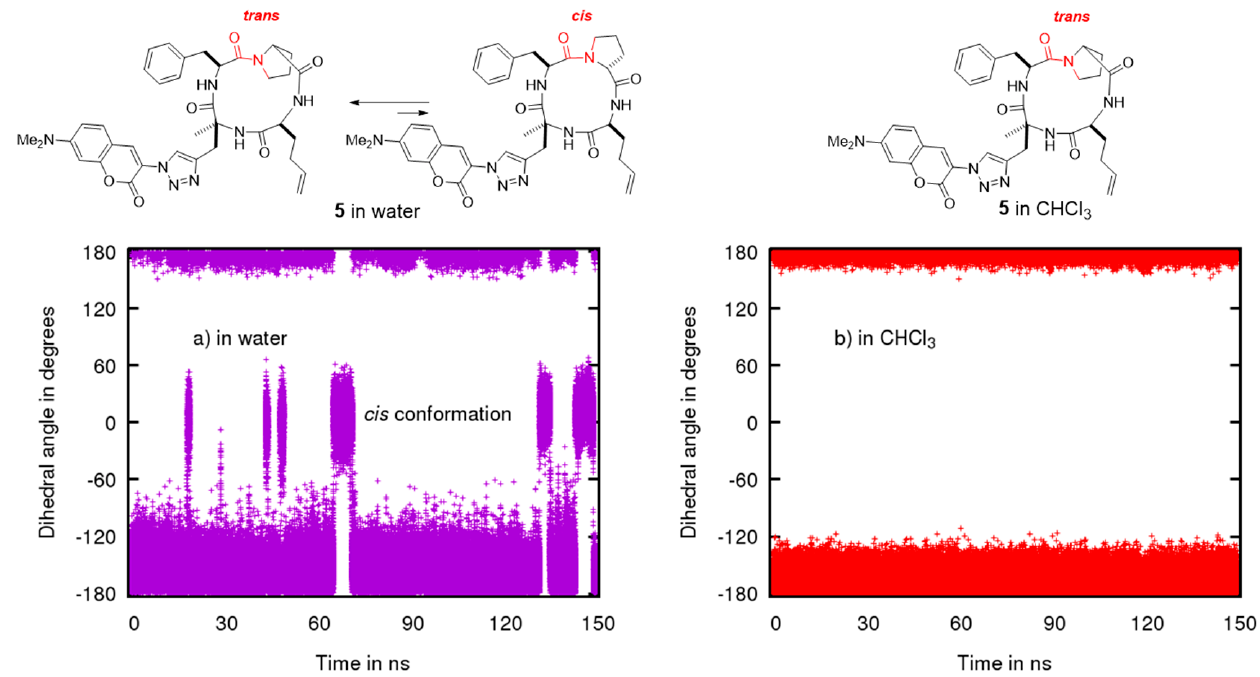
Figure 7. Evolution of the dihedral angle corresponding to the cis/trans isomerization by molecular dynamics (values close to zero correspond to the cis conformation and values close to 180° or − 180° to the trans conformation) ( a ) in water and ( b ) in CHCl 3 . To analyze their conformational difference, the conformers obtained were described in terms of the dihedral angle of the amide bond between proline and phenylalanine (Figure 7) and representative IMHBs (Figures 8 and